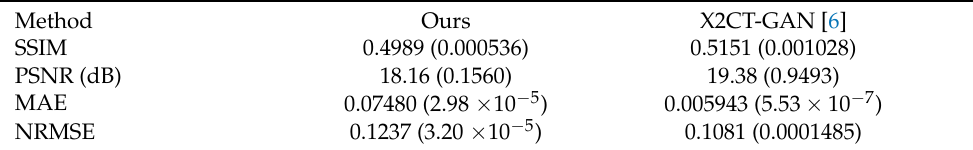
Table 4. Means of metrics ( N = 1, ultra-low-dose protocol). We show variances in brackets.